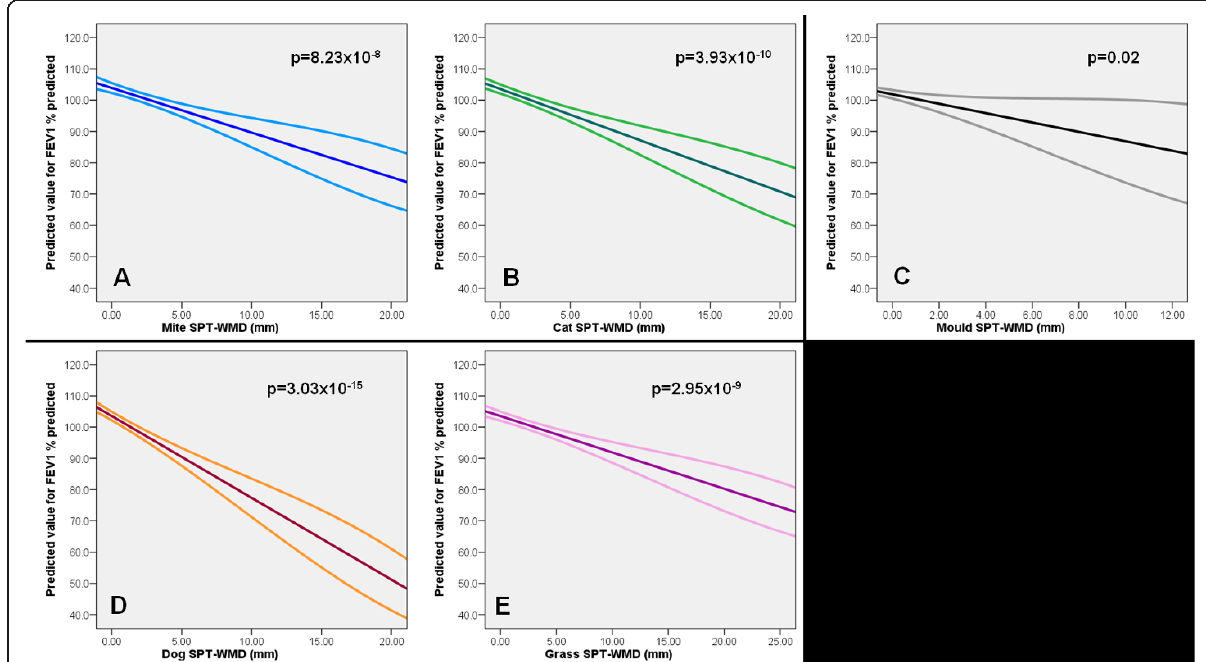
Figure 2 Predicted value for FEV 1 % predicted in relation to sensitization to mite (A), cat (B), moulds (C), dog (D) and grass pollen (E) - SPT-WMD (mm), derived from the linear regression analysis (regression line with 95% CI)